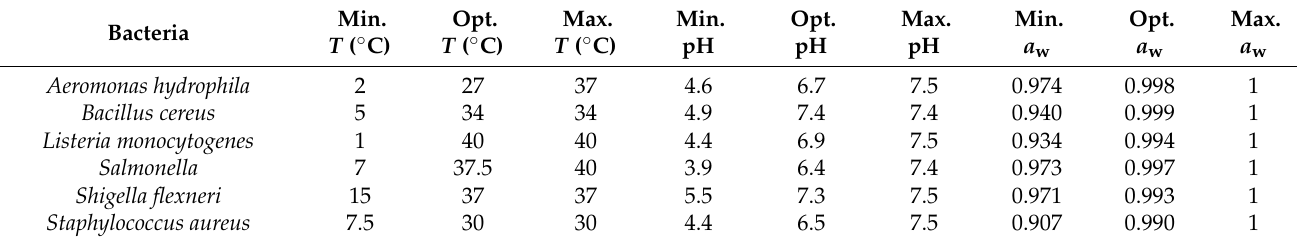
Table 5. Minimum, maximum and optimal parameters for bacterial